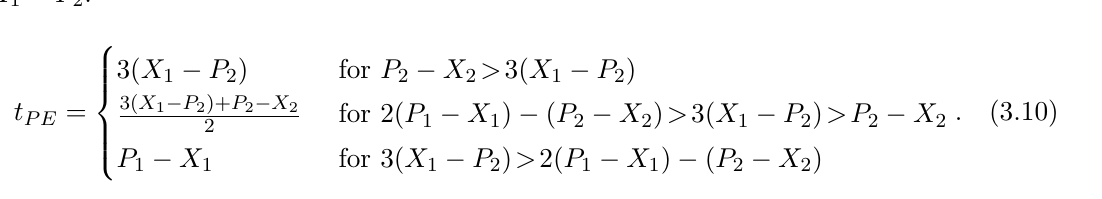
[b] [ ] [b] [ ] [b] [ ] = W = W = W Figure 3: A cartoon of the trajectory of the operator. Orange dashed and dotted arrows Figure 3: A cartoon of the trajectory of the operator. Orange dashed and dotted arrows illustrate the trajectory in t 2 of the operators, while the purple dashed and dotted arrows illustrate the trajectory in t 2 of the operators, while the purple dashed and dotted arrows illustrate that the trajectory in t 1 . In the limits where t 1 illustrate that the trajectory in t 1 . In the limits where t 1 or t 2 , operators or t 2 , operators or t 2 , operators ! 1 ! 1 ! 1 ! 1 ! 1 ! 1 approach 0 or ⇡ . approach 0 or ⇡ . Figure 3: A cartoon of the trajectory of the operator. Orange dashed and dotted arrows Figure 3: A cartoon of the trajectory of the operator. Orange dashed and dotted arrows illustrate the trajectory in t 2 of the operators, while the purple dashed and dotted arrows illustrate the trajectory in t 2 of the operators, while the purple dashed and dotted arrows illustrate that the trajectory in t 1 . In the limits where t 1 or t 2 , operators ! 1 ! 1 approach 0 or ⇡ .